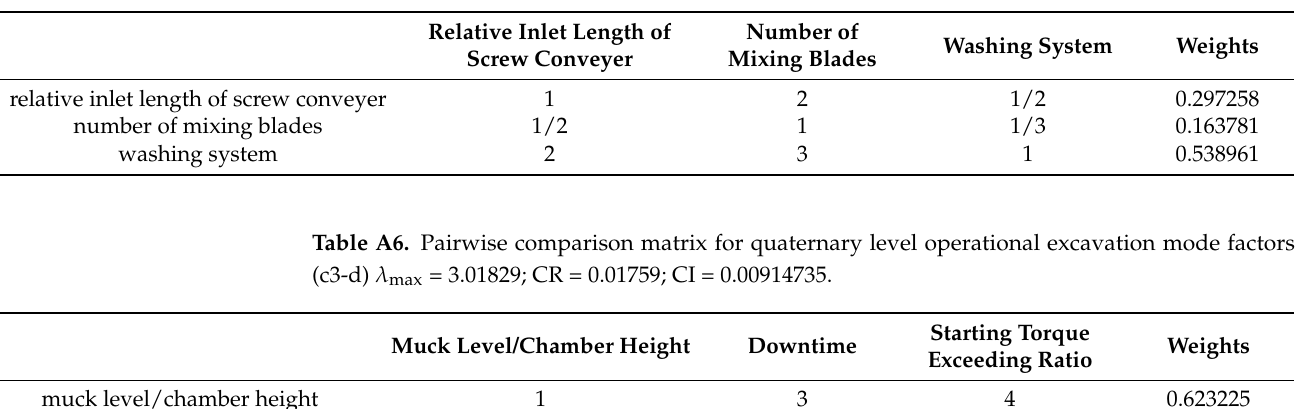
Table A5. Pairwise comparison matrix for quaternary level not cutters machinal factors (b2-c)